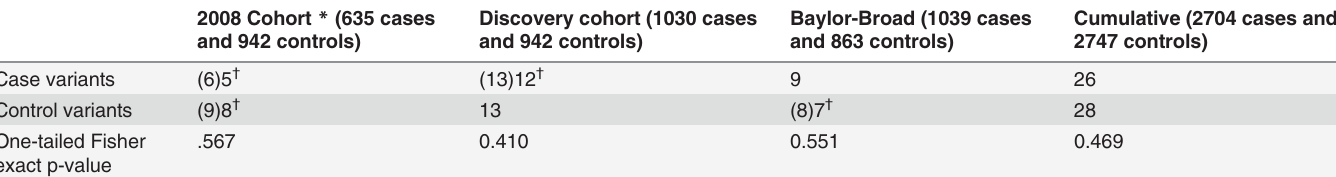
Table 5. Combined CNTNAP2 deleterious variants **